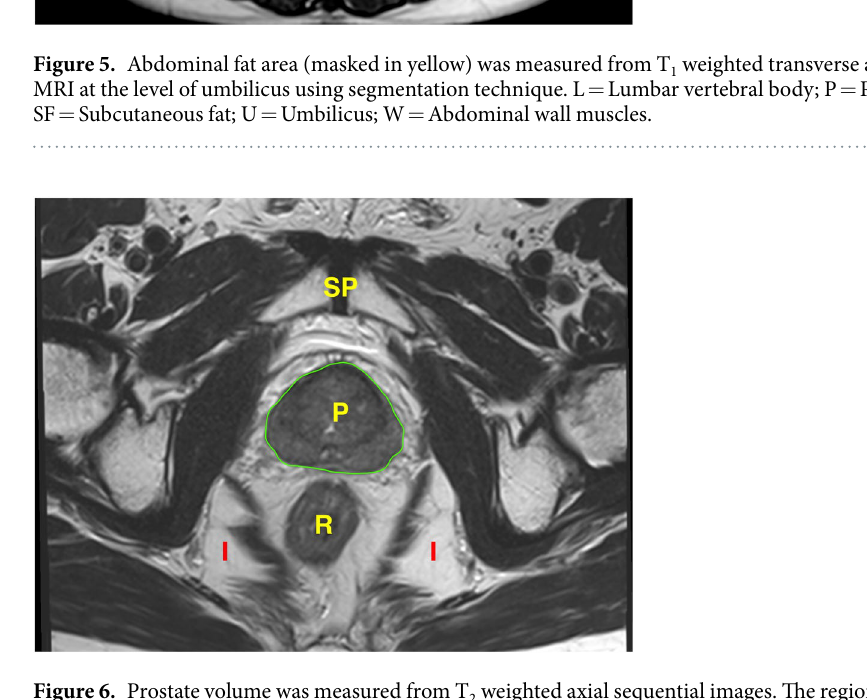
Figure 6. Prostate volume was measured from T 2 weighted axial sequential images. The region of interest was marked manually from each slice using pencil starting from the level of the base of the prostate till the level of its apex. Subsequently the software automatically calculates the volume. P = Prostate gland; R = Rectum; I = Ischiorectal fossa; SP = Symphysis